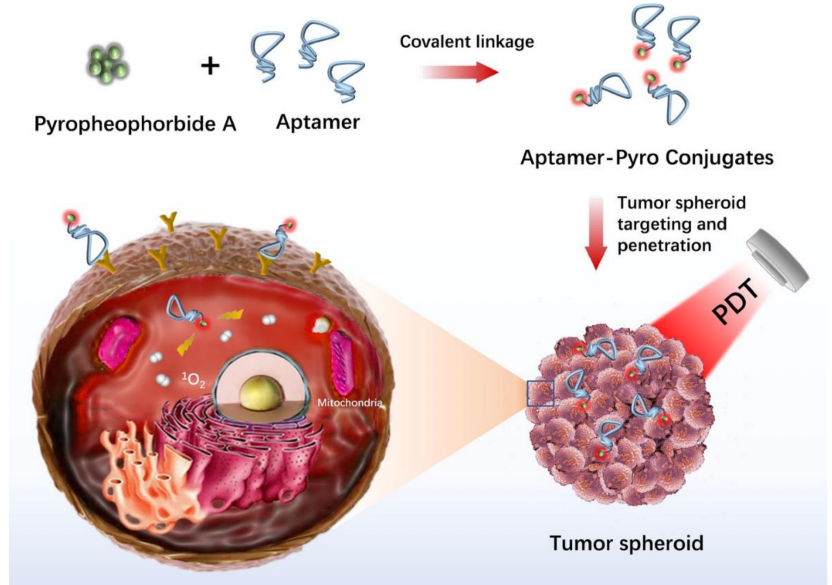
Figure 6. In vitro human cancer models for photodynamic therapy development. Adapted with permission from [109] © ACS Publications